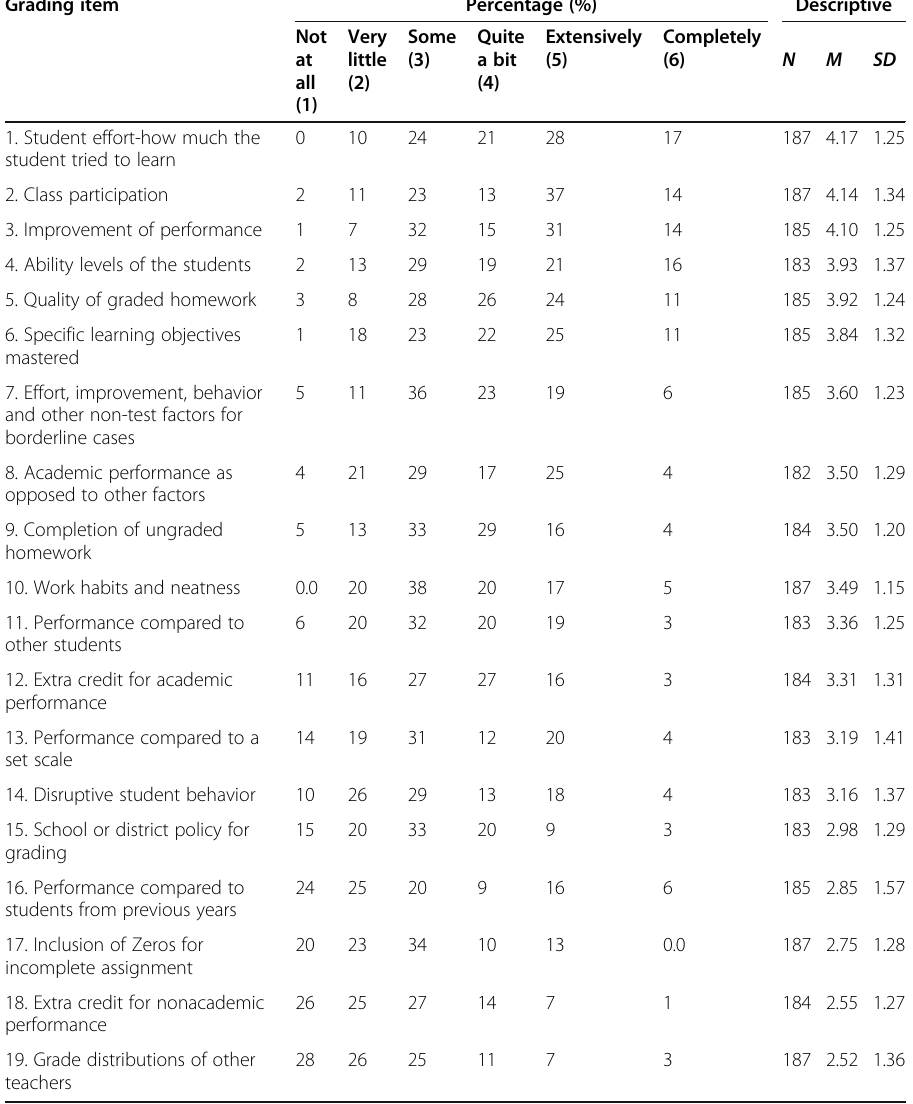
Table 1 Descriptive statistics of grading items used by secondary EFL teachers Grading